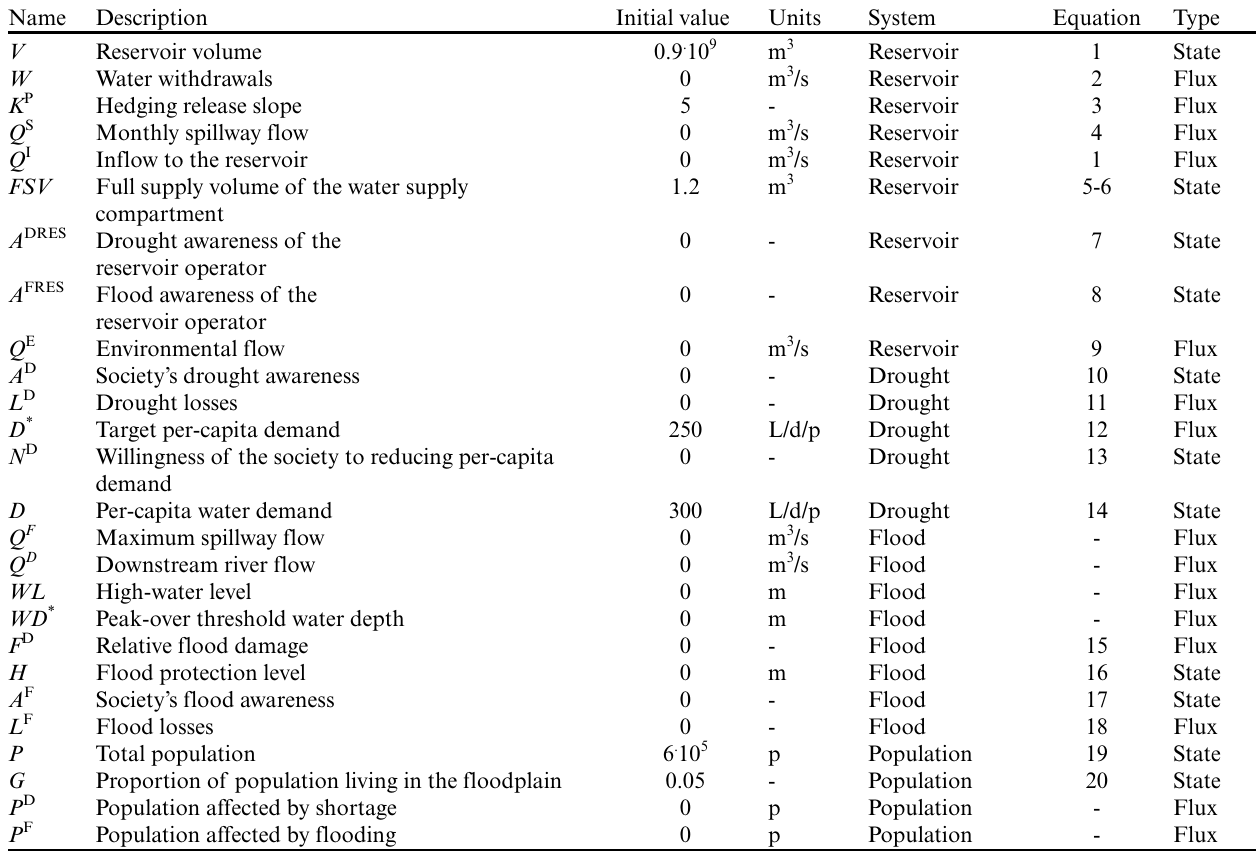
Table 3 . Summary of the state variables and fluxes of the proposed socio-hydrological